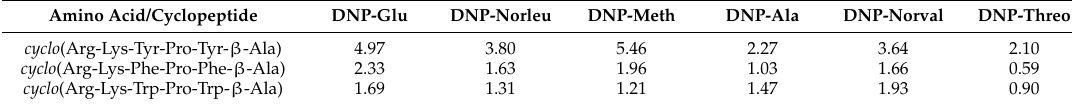
Table 2. Resolution factors R s of DNP-amino acids on cyclohexapeptides by CE (conditions as in Figure 6) [49].